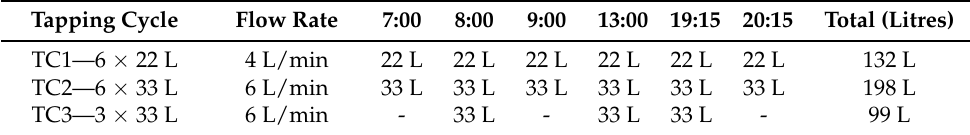
Table 2. Consumption timetable for the designed tapping